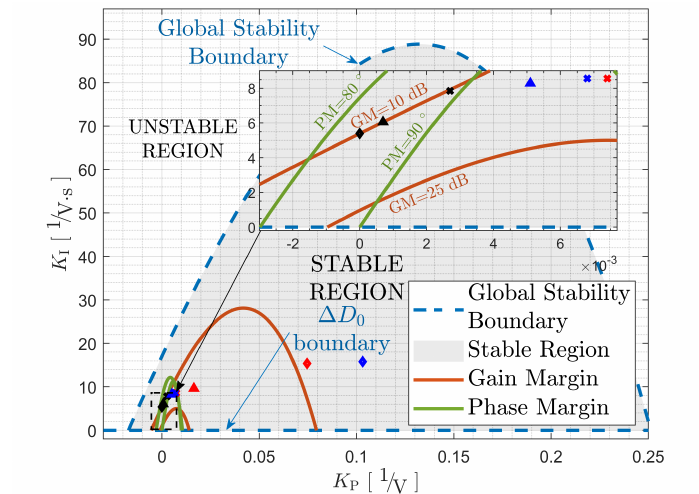
Figure 8. Visualisation of the global stability boundary and selected GM and PM trajectories, ( s ) transfer function with closed loop GM ∈ (cid:104) 10;25 (cid:105) dB and PM ∈ (cid:104) 80;90 (cid:105) ◦ , calculated for P exp,est,c2o Boost control structure shown in Figure 6. The trajectories have been calculated according to Equations (22) to (25). The red, blue and black points represent the selected in Section 4 gains with unconstrained GA, global stability constrained GA and the GM & PM constrained GA respectively. The cross, triangle and diamond stand for the IAE, ITAE and ISTAE